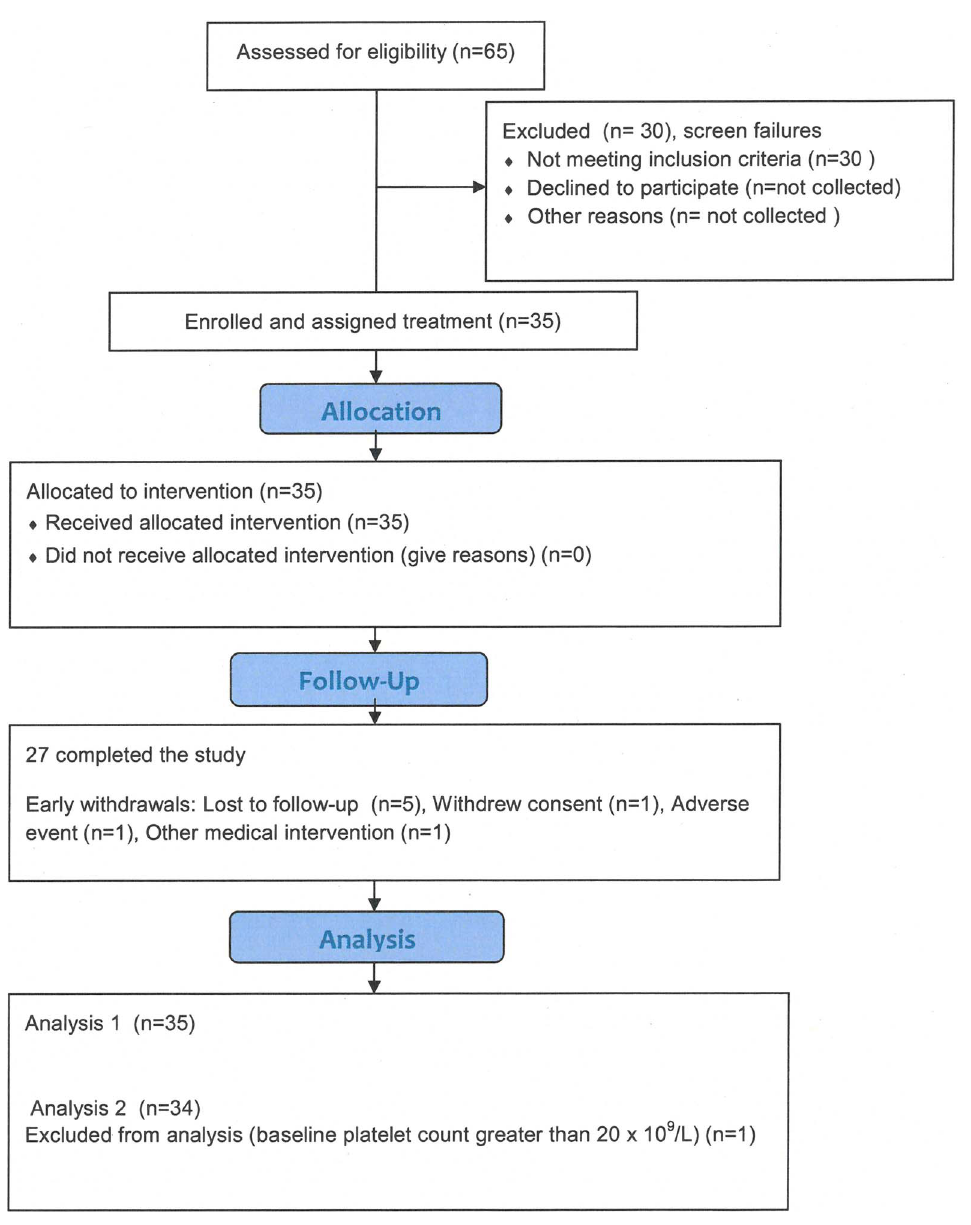
Figure 1. Flow diagram for patients enrolled.